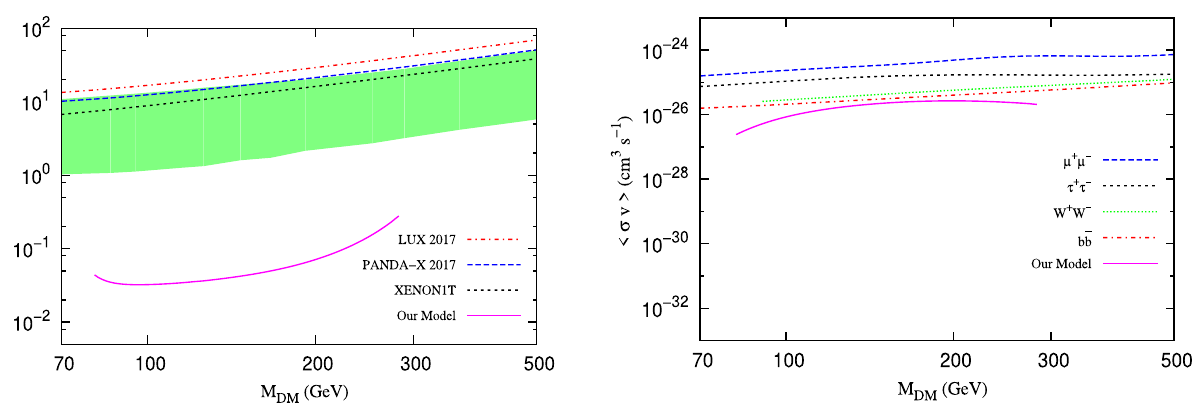
Fig. 1 Spin-independentcross-sectionoftheprotonasafunctionofthe DMmassinourmodel(magentacurve),andtheexperimentalupperlim- its from LUX(red curve) [82], PANDA-X(blue curve) [83], XENON1T (dotted black curve with 90% C.L. and 2 σ sensitivity bands (green band)) [84]